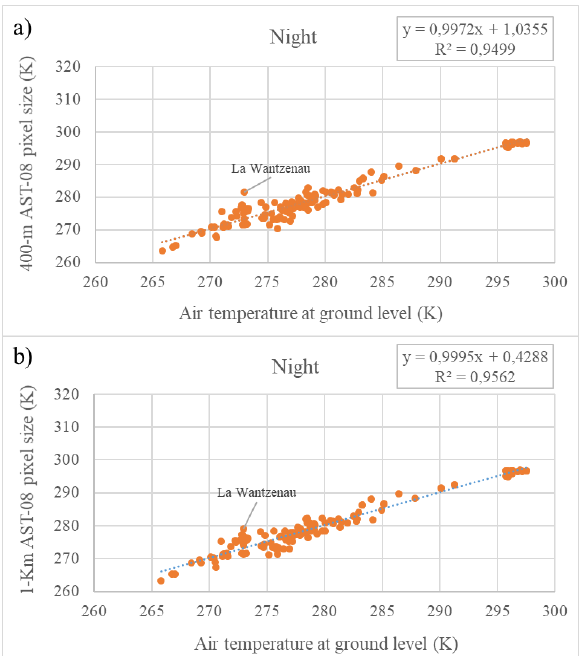
Figure 3. Example of second-degree polynomial interpolation between hourly temperature data registered by the meteorological stations in order to get the temperature at 21:18.